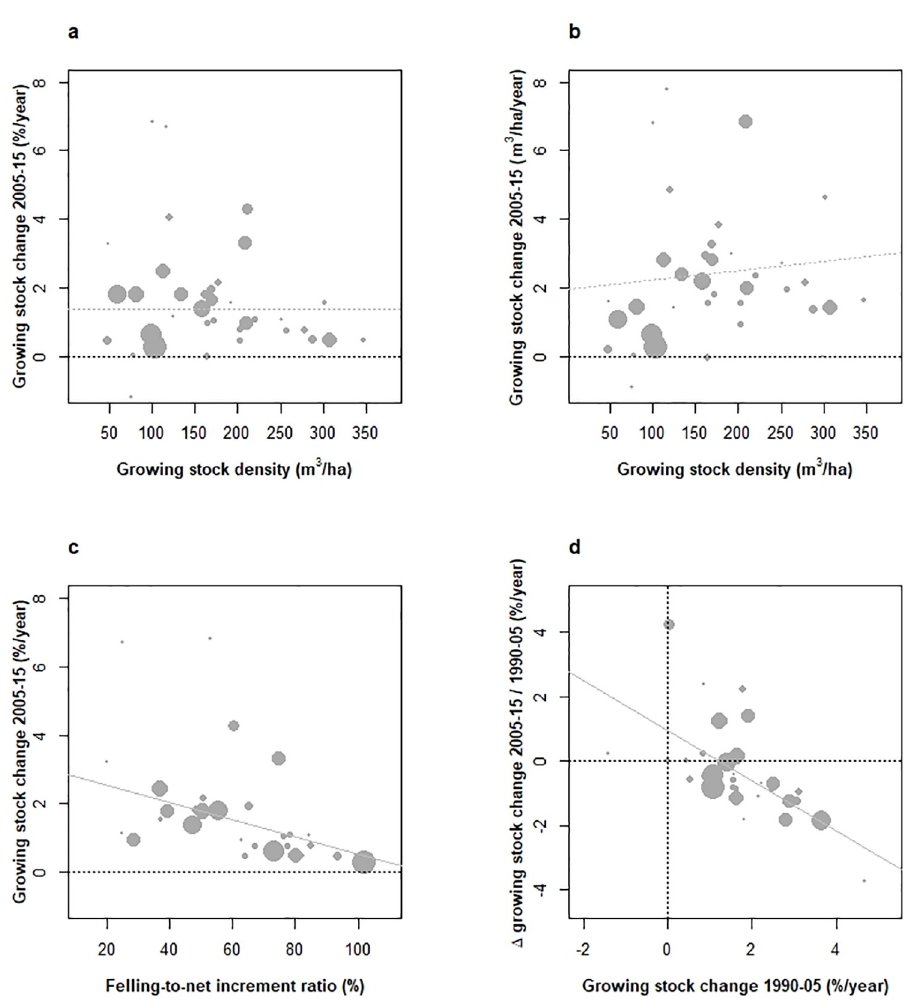
Fig 3. Changes in the forest growing stock of European countries under study over 2005–2015 and their dependence on forest dynamic attributes. Relationships between annual rates of change in the growing stock (2005– 2015) against growing stock density (a), felling- to-net-increment ratio (c). Change in the growing stock (2005–2015) was also expressed per hectare (b) for a cross-comparison with (a). Acceleration in growing stock changes over the two successive periods 1990–2005 and 2005–2015 (difference, %.year –1 ) against initial growing stock changes (d). Weighted correlations are: (a) 0.00 (NS), (b) +0.36 (0.02), (c) -0.44 (p < 0.01), (d)– 0.59 (p < 10 − 4 ). NS correlations figured as dotted